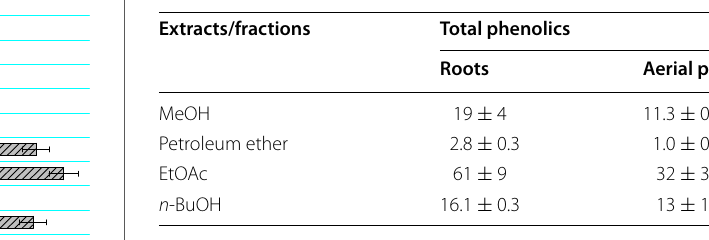
Table 3 Total phenolic content (% of dry extract) in differ- ent extracts and fractions of G. urbanum